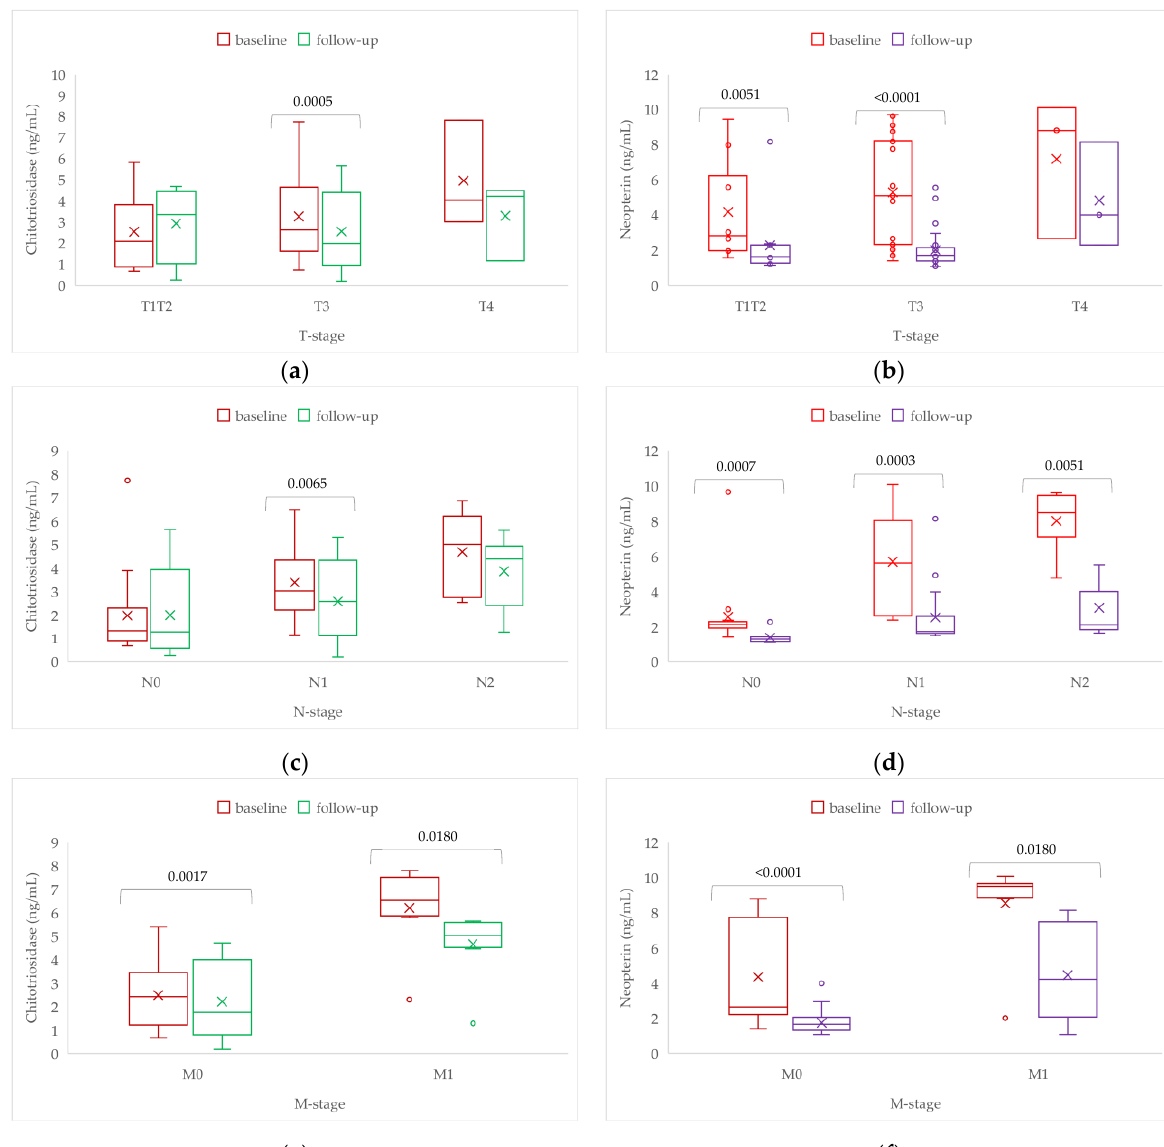
Figure 4. Baseline vs. 1-year follow-up chitotriosidase and neopterin differences according to ( a ) and ( b ) T-stage; ( c ) and ( d ) N-stage; ( e ) and ( f ) M-stage. The × in the box indicates the mean value, the line in the box corresponds to the value of the median, the lower and upper bound of the box corresponds to the value of the first (lower) and third (upper) quartile, and the whisker corresponds to the values of minimum and maximum. The extreme values are shown as “o”. The differences between baseline and follow were tested with Wilcoxon matched pairs test.